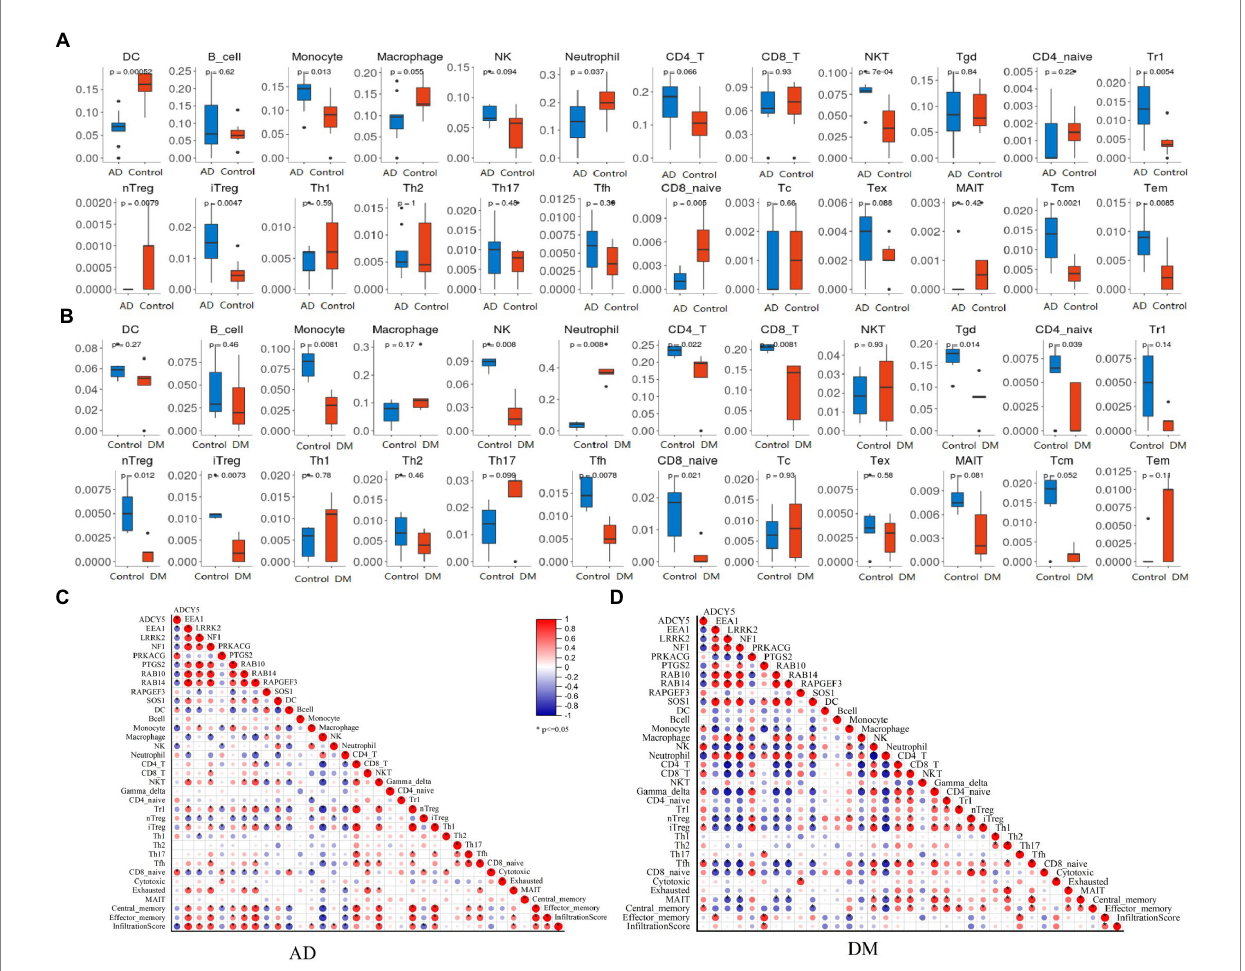
FIGURE 6 Immune infiltration analysis. (A) Analysis of immune infiltration in an AD group (blue) and blank group (red), (B) Analysis of immune infiltration in DM group (red) and blank group (blue), (C) Analysis of the relationship between Hub gene and immune infiltration in the AD group, and (D) Analysis of the relationship between Hub gene and immune infiltration in the DM group. Unpaired t -test, Mean ± SD, p -value <0.05 was considered